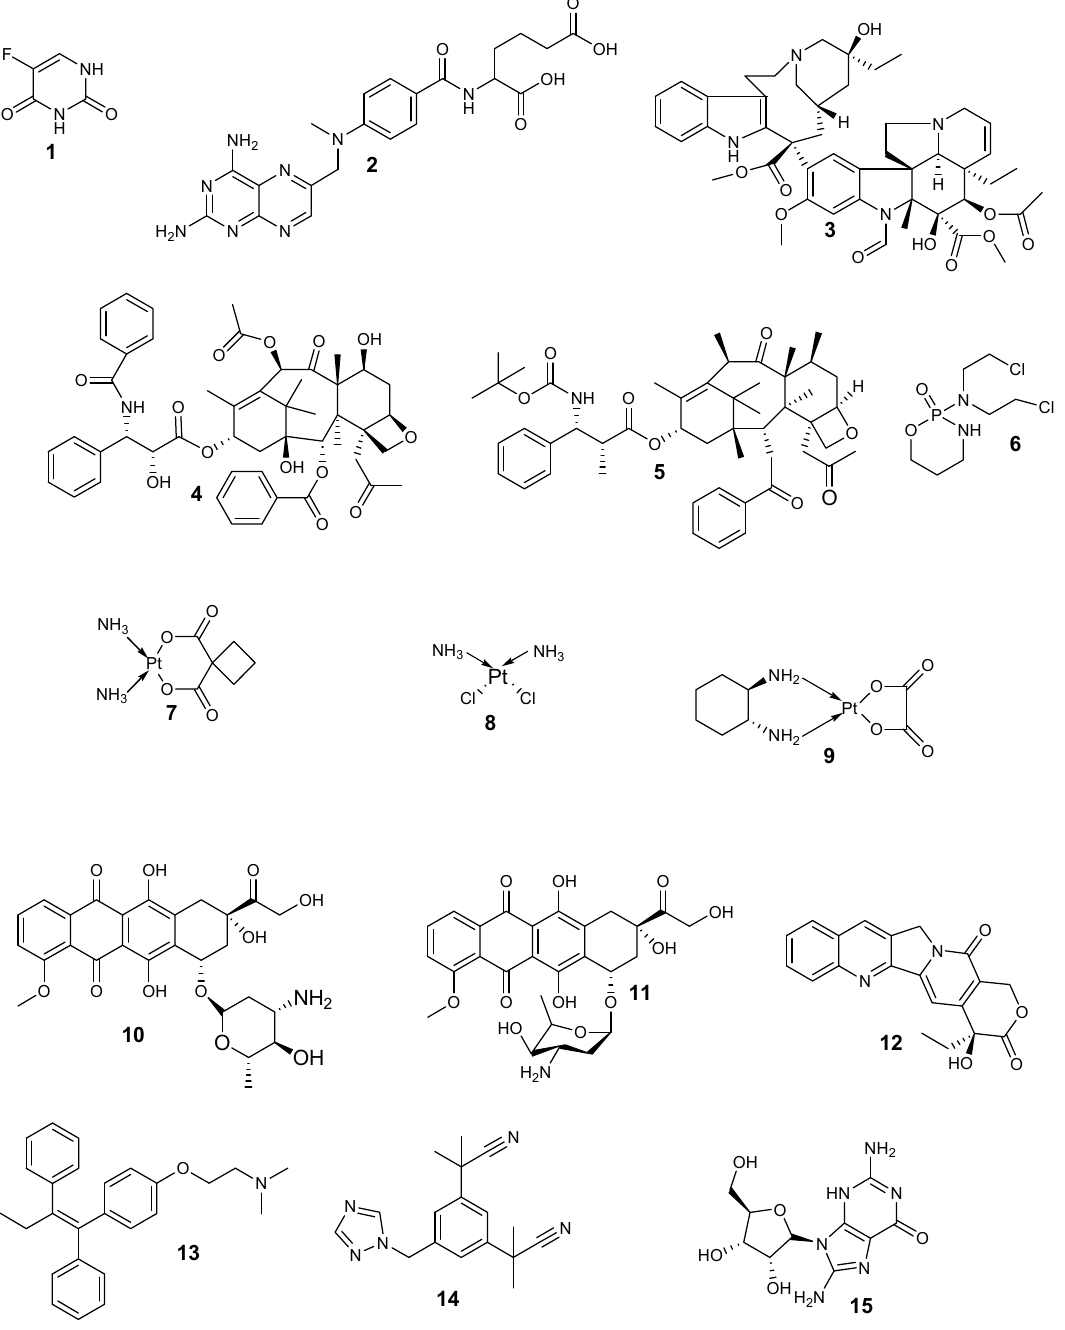
Figure 1. Anticancer drugs used for the treatment of breast cancer: fluorouracil ( 1 ), methotrexate ( 2 ), vincristine ( 3 ), paclitaxel ( 4 ), docetaxel ( 5 ), cytoxan ( 6 ), carboplatin ( 7 ), cisplatin ( 8 ), oxaliplatin ( 9 ), epirubicin ( 10 ), doxorubicin ( 11 ), camptothecin ( 12) , tamoxifen ( 13 ), arimidex ( 14 ) and trastuzumab ( 15 ).